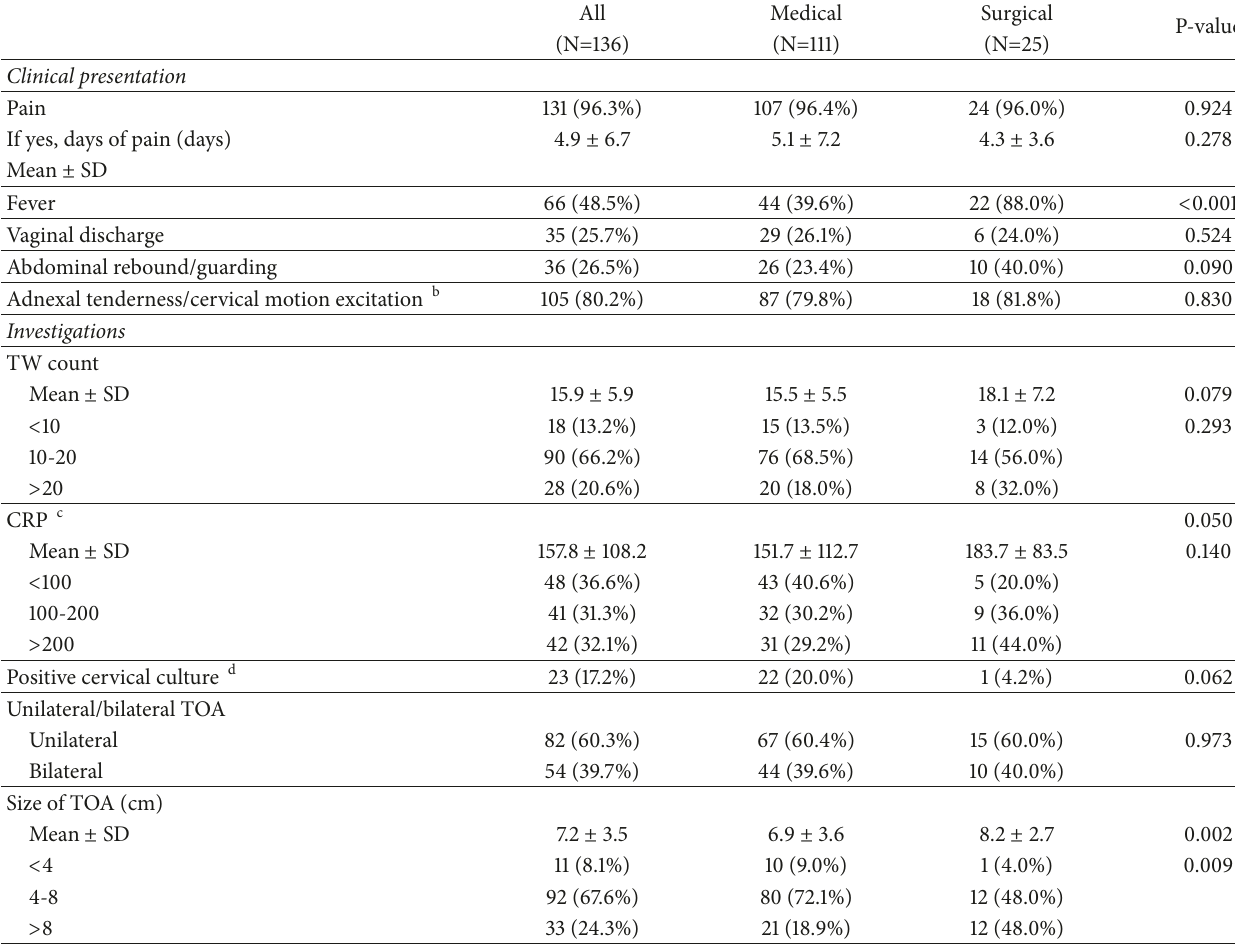
Table 2: Comparison of clinical parameters on admission between the two